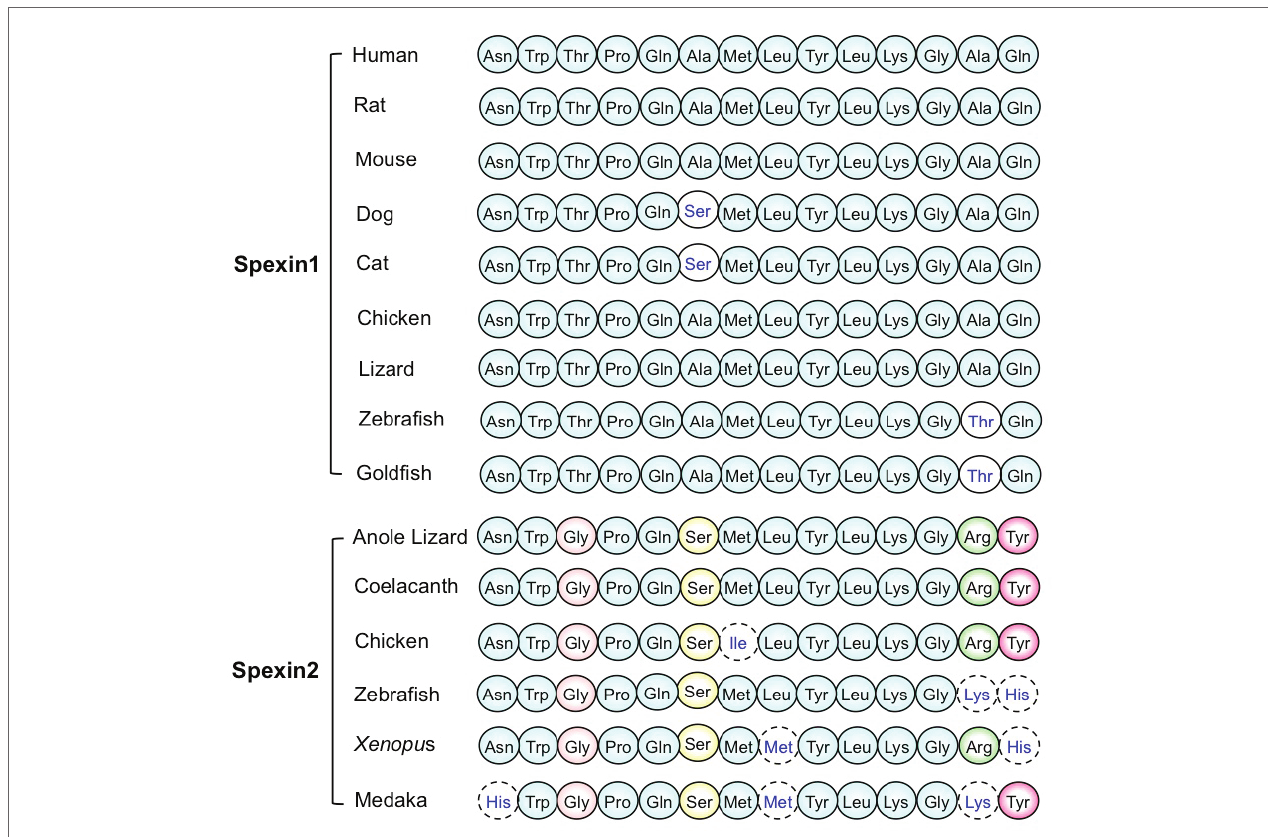
FIGURE 1 | The amino acid sequence of mature spexin1 and spexin2 in various species. (The figure modified from Wong et al., 2013; Kim et al.,